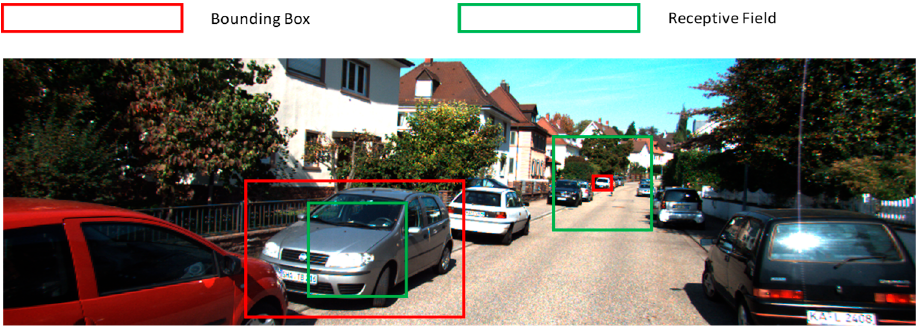
Figure 1. Mismatch of the receptive field and the vehicle bounding box.